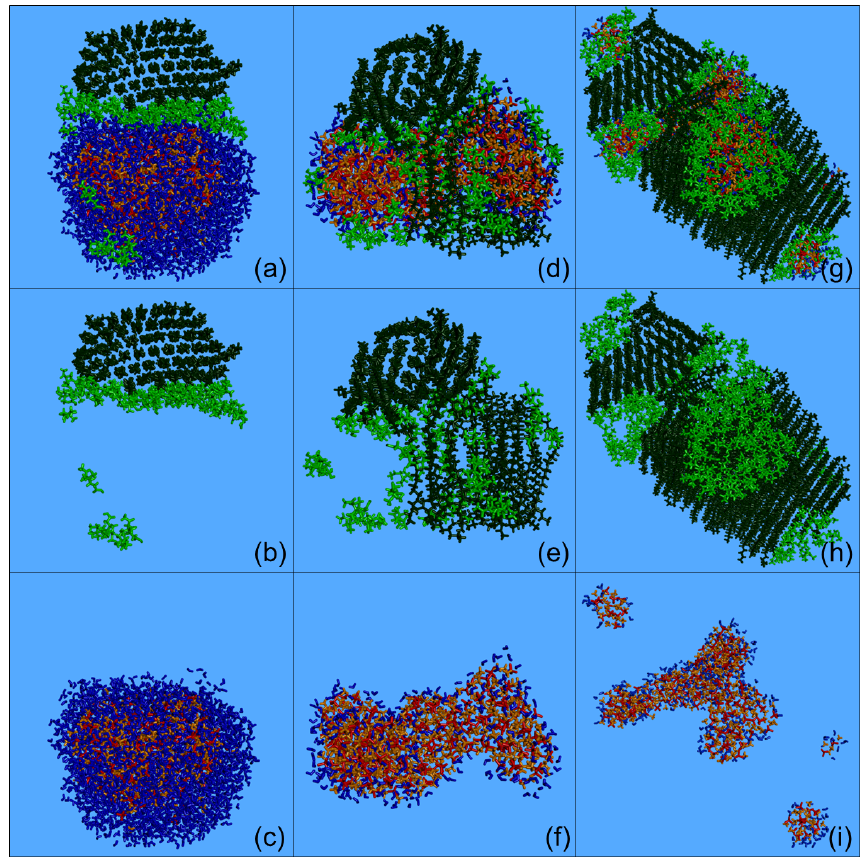
Figure 11. Characteristic snapshots from the MD simulations of the nanoparticle containing CPA and n -triacontane: (a) at 88% RH (53% dry organic content), (b) at 88% RH (53% organics) showing only organic molecules, (c) at 88% RH (53% organics) omitting organic molecules, (d) at 40% RH (53% dry organic content), (e) at 40% RH (53% organics) including only organic molecules, (f) at 40% RH (53% organics) omitting organic molecules, (g) at 39% RH (82% dry organic content), (h) at 39% RH (82% organics) including only organic molecules and (i) at 39% RH (82% organics) omitting organic molecules. Colour coding: green for CPA, dark green for n -triacontane, red for sulfate, orange for ammonium and blue for